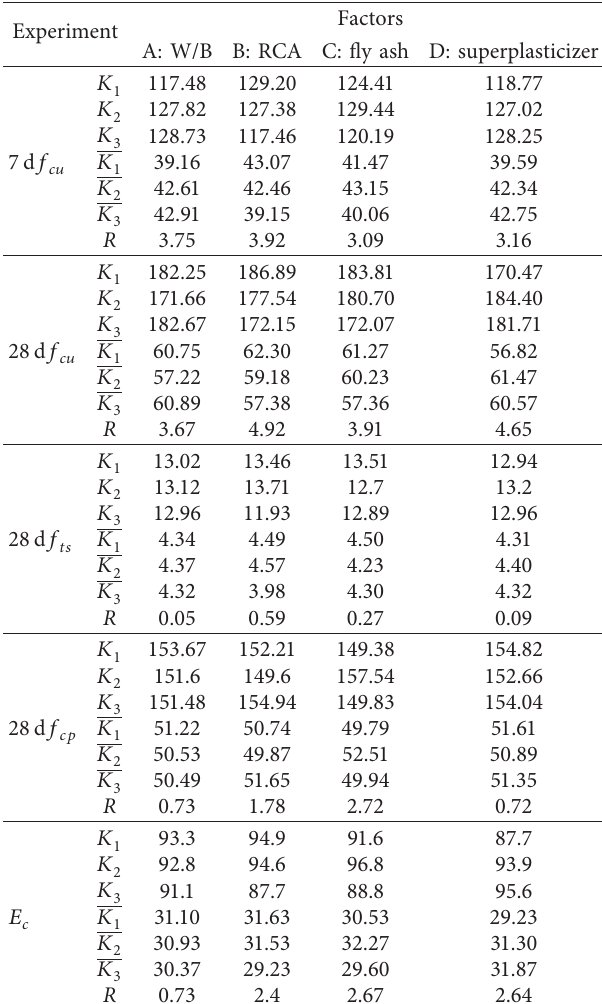
Table 12: Range method analysis of mechanical